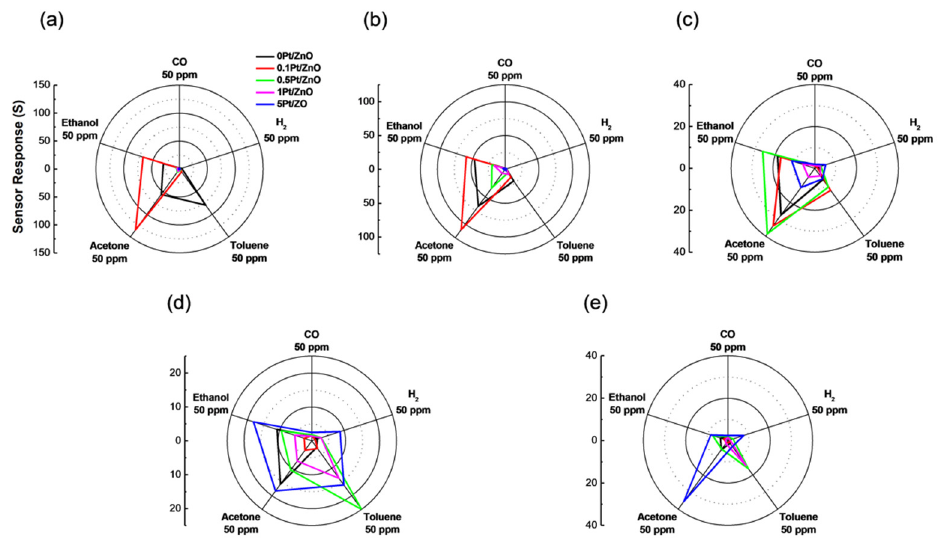
Figure 5. Sensor responses of Pt-ZnO NCs to five test gases at ( a ) 400; ( b ) 350; ( c ) 300; ( d ) 250; ( e ) 200 °C under dry conditions.